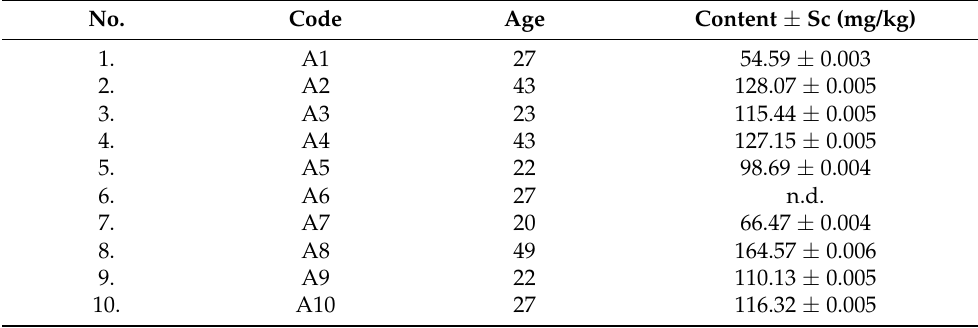
Table 8. Arsenic levels in hair